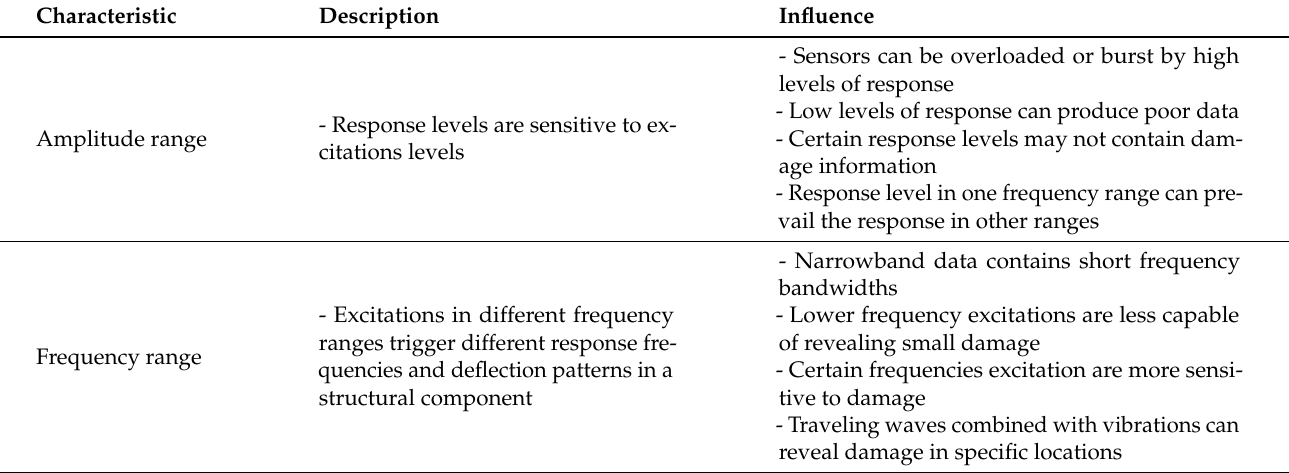
Table 8. The criteria based on which the type of sensors need to be